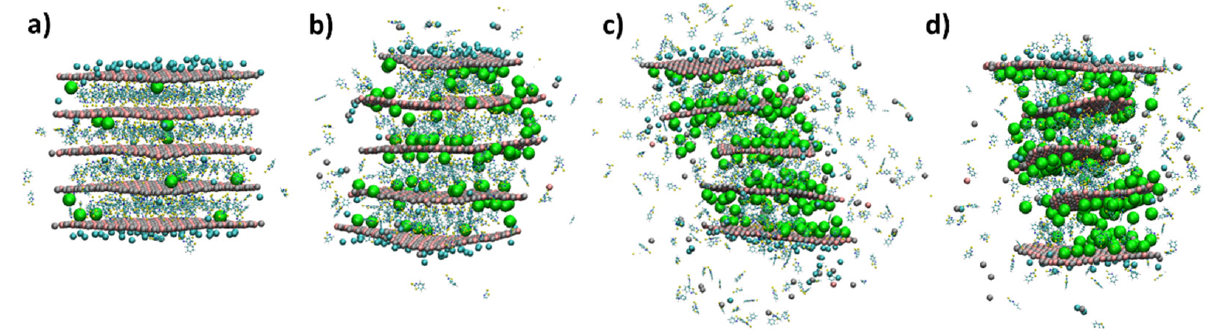
Figure 4. Snapshots of different stages of the MD simulation for LDH-MBT. After the NVT equi- libration (( a ), 0 ns), NpT equilibration (( b ), 5 ns), and the production runs of 50 ns (( c ), 60 ns and ( d ), 110 ns). The chemical elements’ color code is ochre for Al, silver for Zn, red for O, and white for H. Cl inside the LDH are in green, while cyan was used for external Cl (surface Cl) at less than 5 Å of Al and Zn. The MBT − anions intercalated in the LDH galleries are represented with a ball-and-stick model, using blue for N, yellow for S, cyan for C, and white for H. Magnified versions of the panels presented in this Figure are provided in the SI (Figure